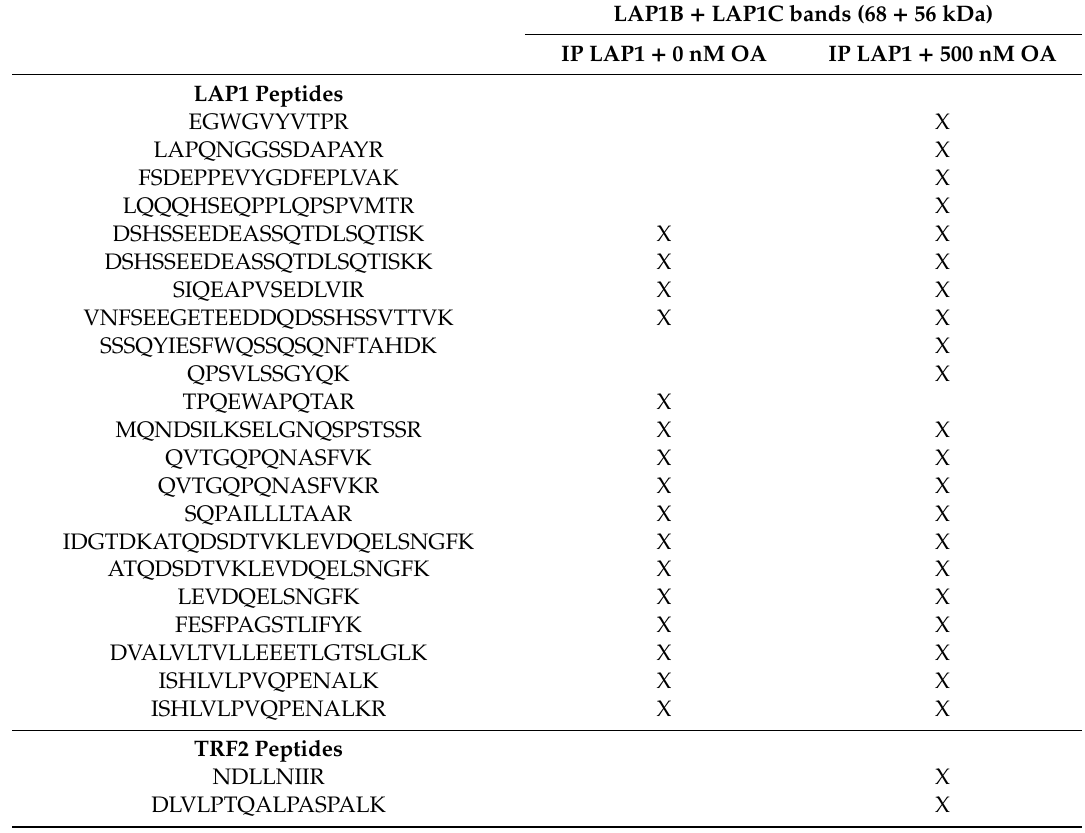
Table 1. HPLC–MS-based identification of TRF2 as a LAP1-interacting protein in vivo after inhibition of serine / threonine-specific PP1 / PP2A phosphatase activity in the human SH-SY5Y cell line. Whole cell lysates obtained in normal conditions or after okadaic acid treatment (500 nM for 3 h) were immunoprecipitated using a LAP1-specific antibody conjugated to Dynabeads Protein G, followed by SDS–PAGE and HPLC–MS analysis of LAP1B and LAP1C protein bands ( ≈ 68 and 56 kDa, respectively). Unique LAP1 and TRF2 peptides identified in each experimental condition are listed. LAP1B + LAP1C bands (68 + 56 kDa) IP LAP1 + 0 nM OA IP LAP1 + 500 nM